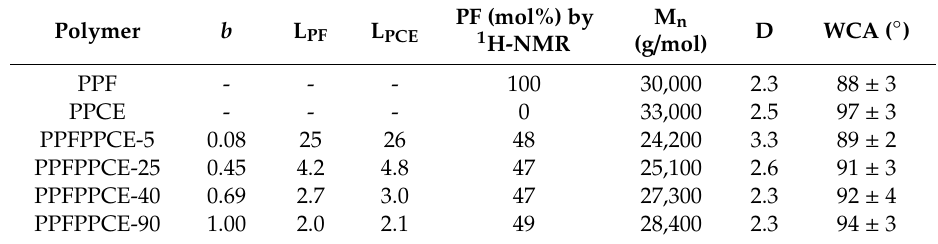
Table 1. Molecular characterization and wettability data of PPF, PPCE, and PPFPPCE-t copolymers.